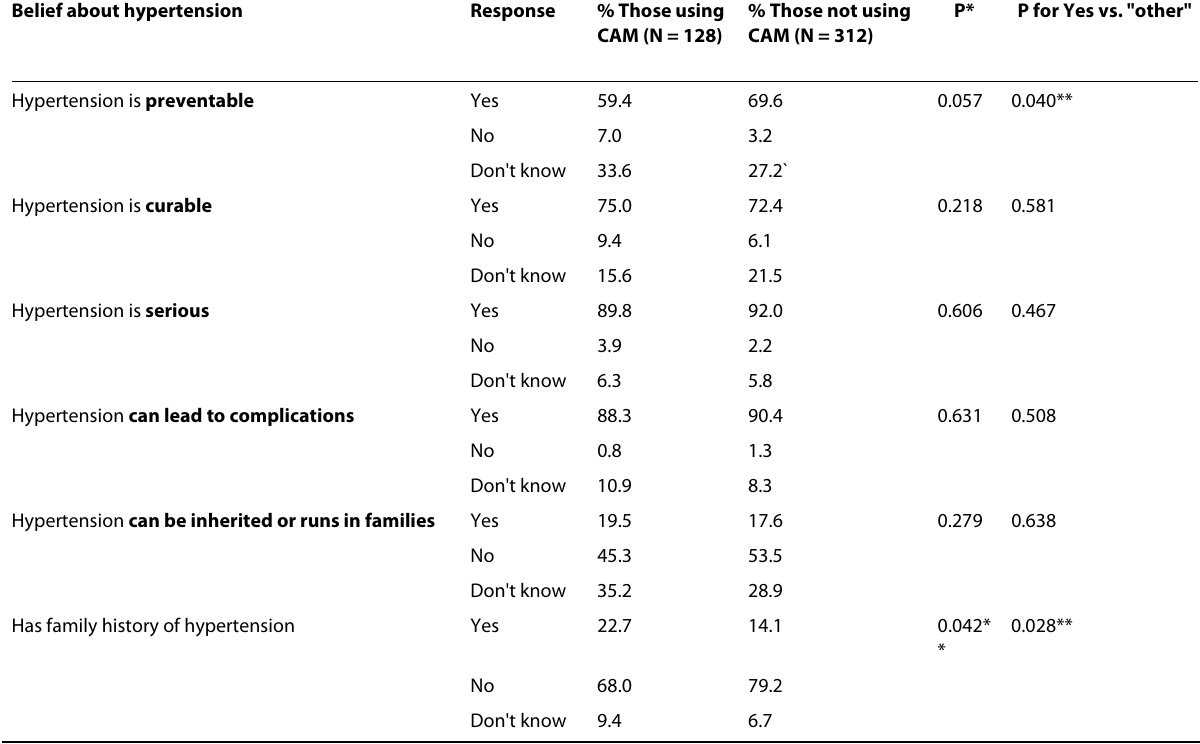
Table 4: Use of CAM and other beliefs about hypertension Belief about